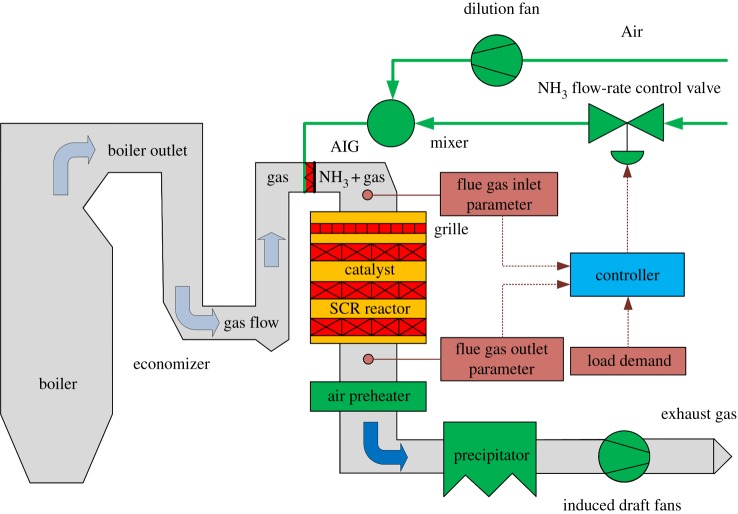
The flow chart of the SCR de-NOx process.